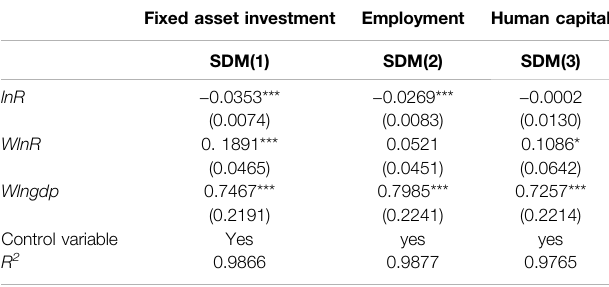
TABLE 8 | Regression results of Classi fi cation discussion. (Fixed Asset Investment, Employment and Human Capital). Fixed asset investment Employment